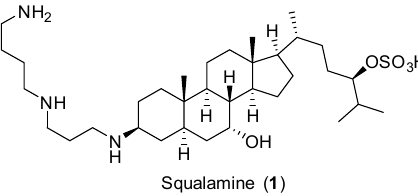
Figure 1. The structure of squalamine ( 1 ).